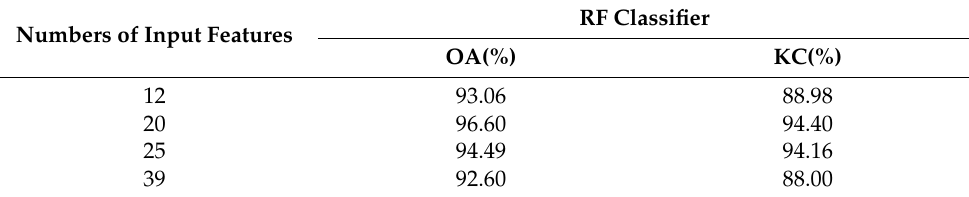
Table 2. Accuracy assessment of different input features